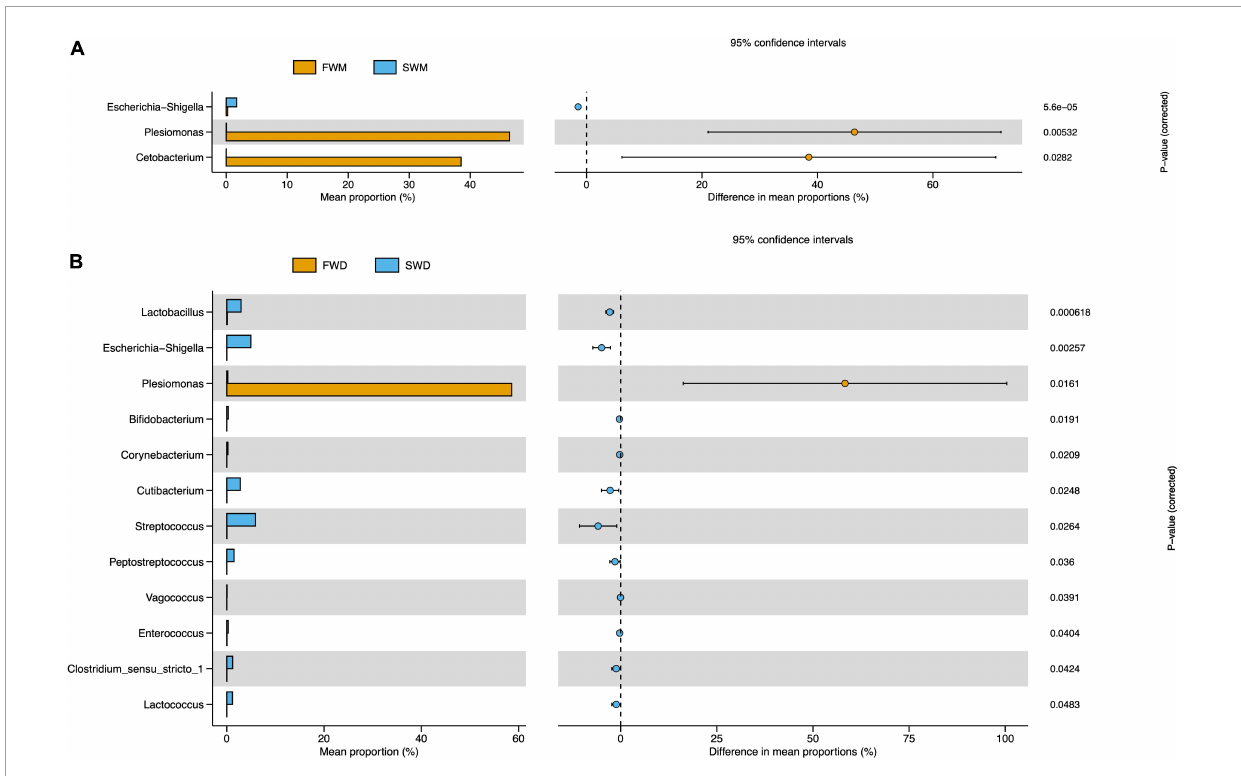
FIGURE4 STAMP analysis revealed differentially abundant species between (A) FWM and SWM and (B) FWD and SWD. FWD, freshwater digesta samples; SWD, seawater digesta samples; FWM, freshwater mucosa samples; SWM, seawater mucosa